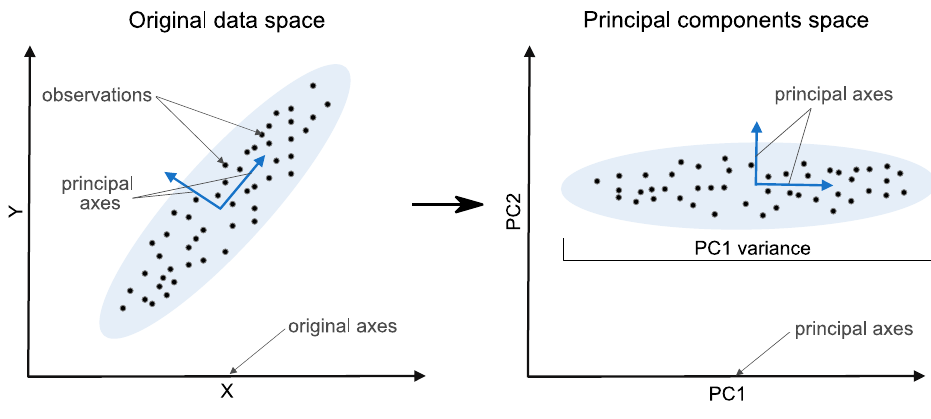
Figure 12. Principal component analysis.